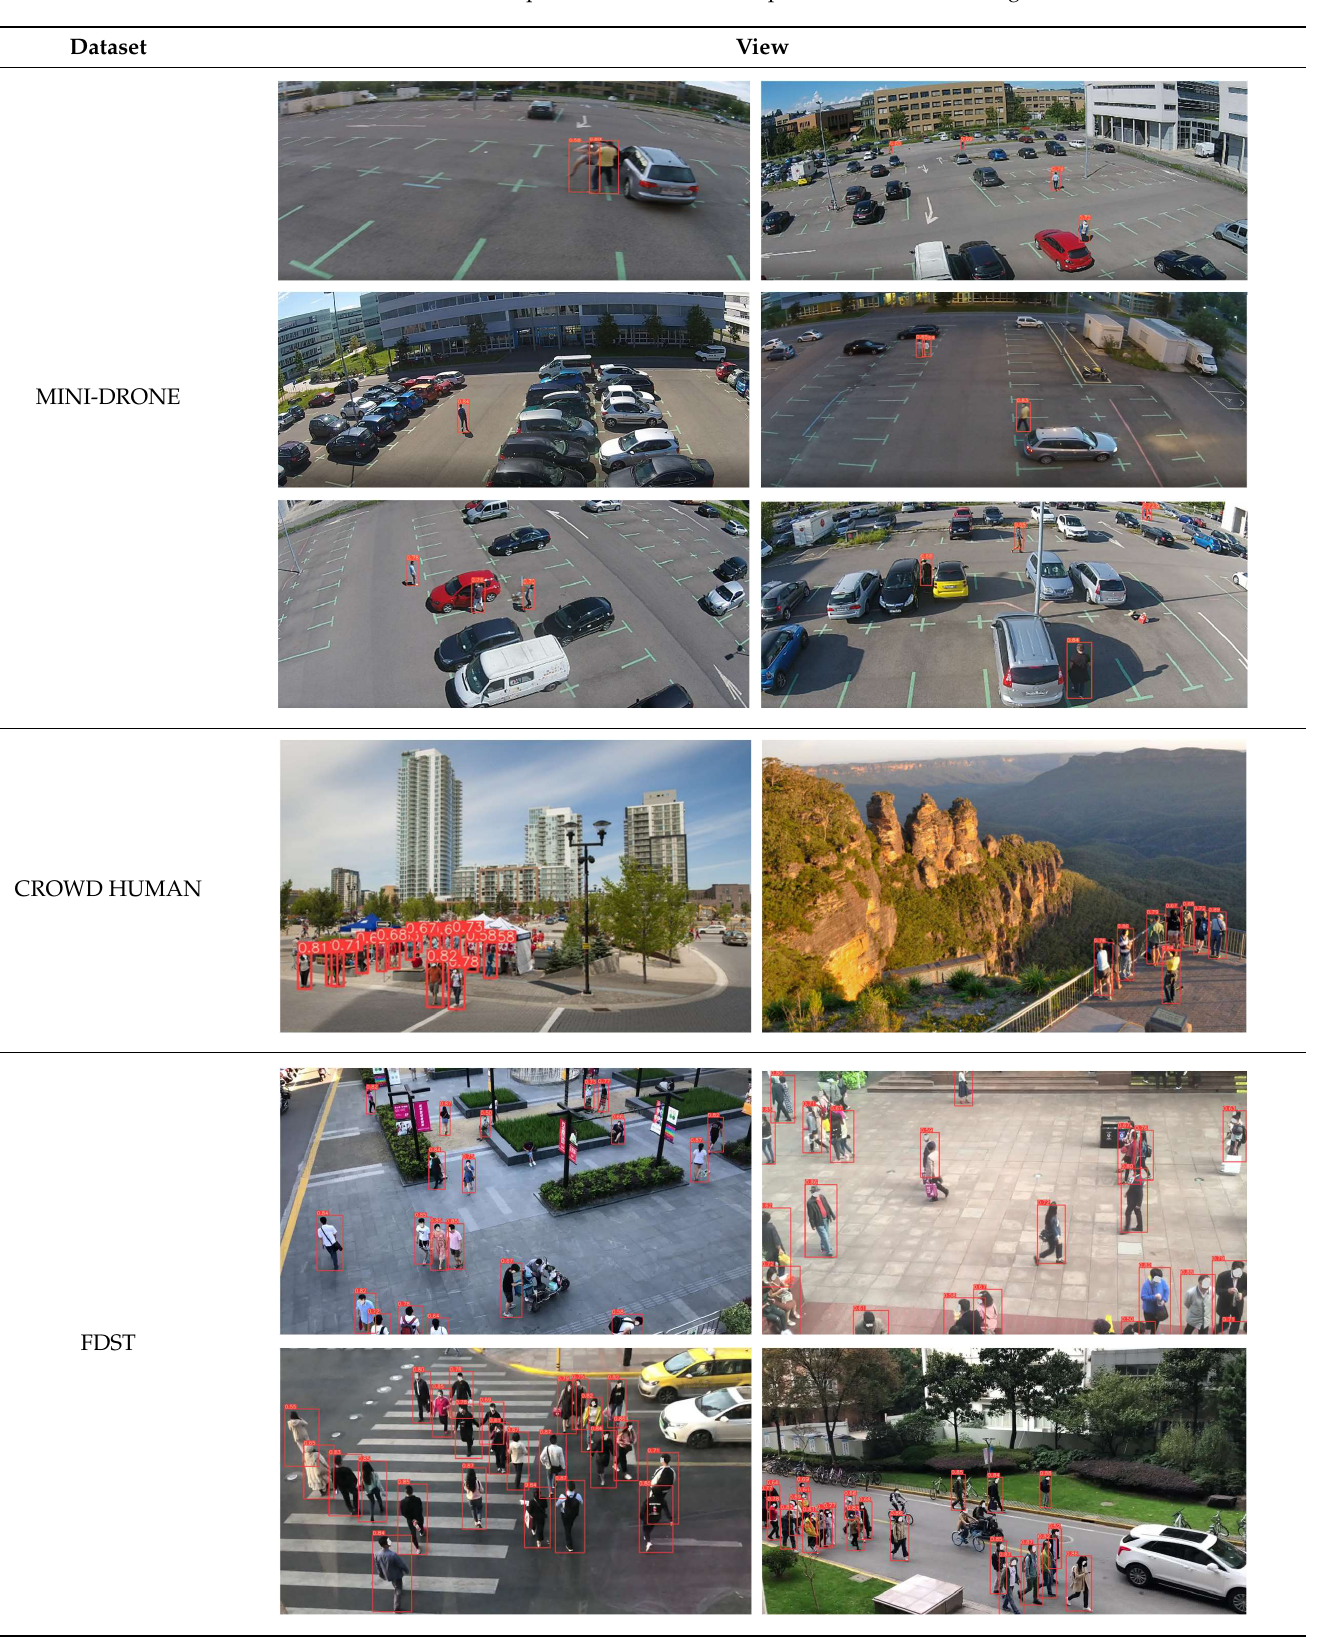
Table 8. Quantitative person detection results per selected videos/images via the custom